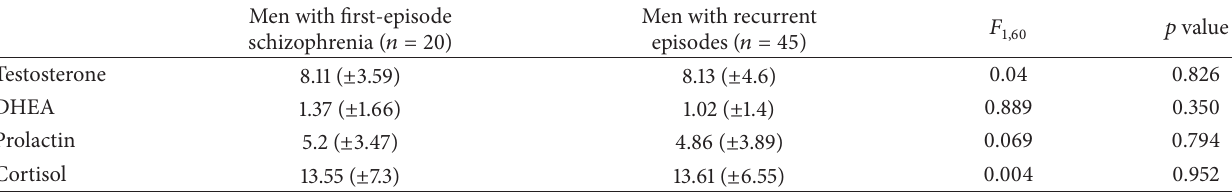
Table 7: Comparison using multivariate analysis of variance (MANOVA) of serum hormones levels in men with first-episode schizophrenia disorder and recurrent